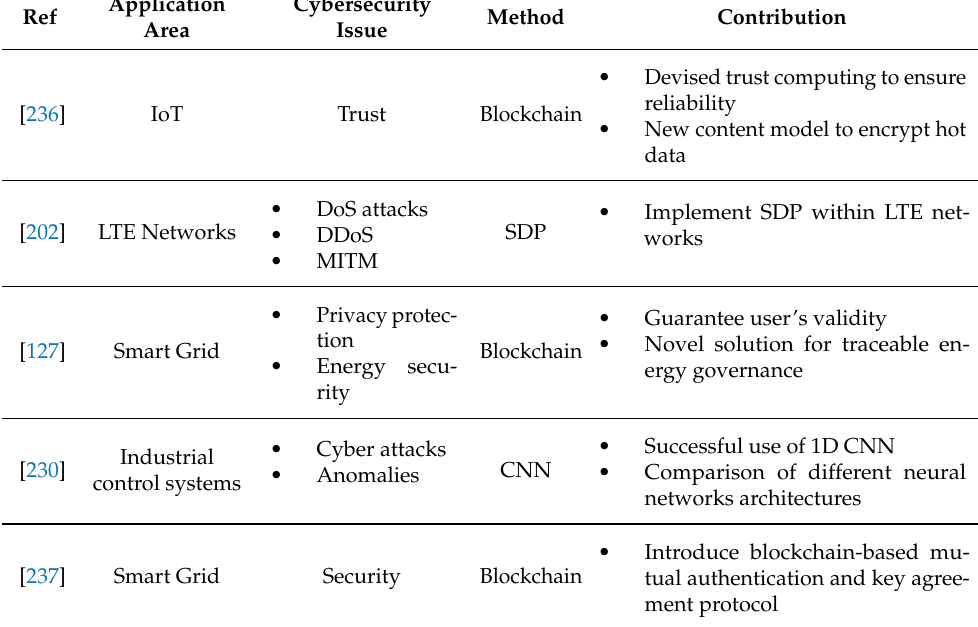
Table 7. Comparison of Different Cybersecurity